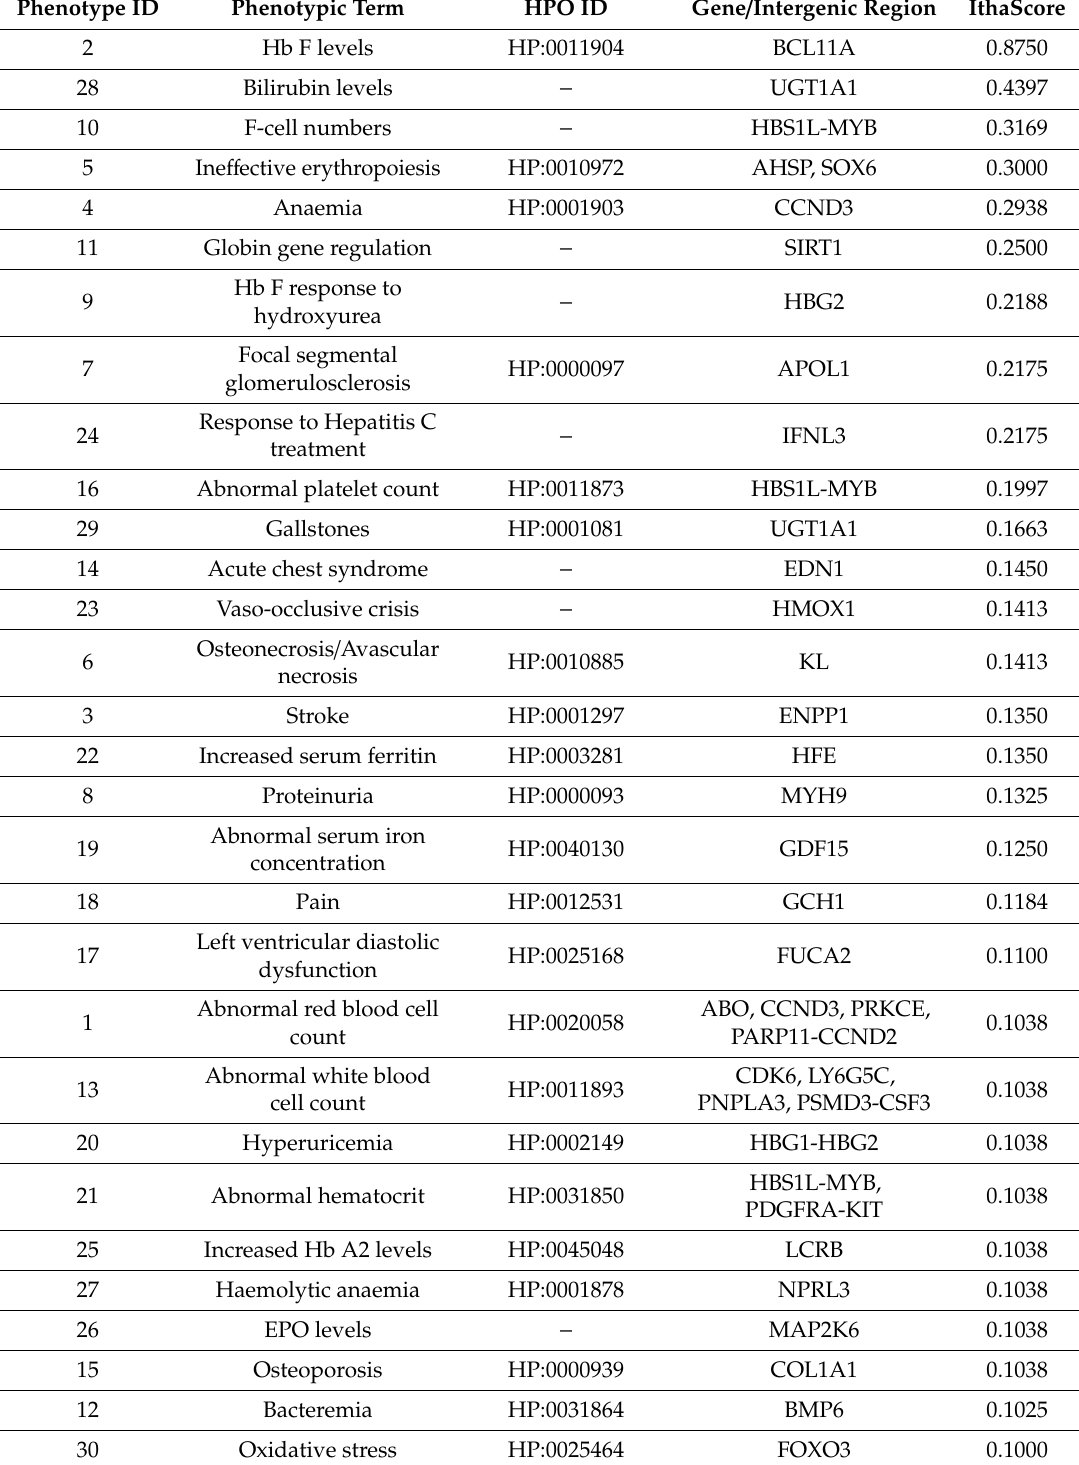
Table 2. The gene with the highest IthaScore for each phenotype. “Phenotype ID” column indicates the identifier assigned to each phenotype throughout this